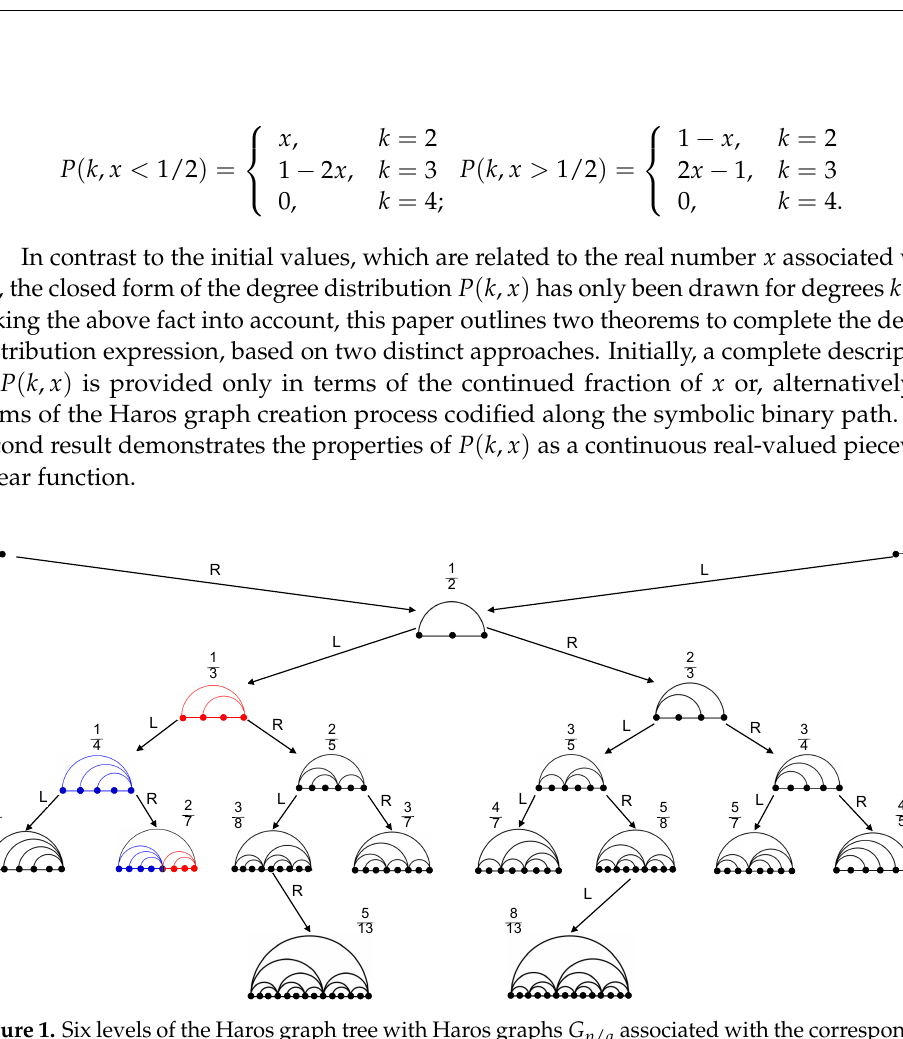
Figure 1. Six levels of the Haros graph tree with Haros graphs G p / q associated with the corresponding rational fractions p / q (due to space constraints, only two of these are shown at the sixth level). The first level is formed by two copies of the initial graph G 0 . The graph operator merges the two nearby extreme nodes, adding a connection to the resulting graph that connects the new extreme nodes. On the left, the Haros graph G 2/7 is generated by concatenating G 1/4 (blue) and G 1/3 (red), i.e., G 2/7 = G 1/4 ⊕ G 1/3